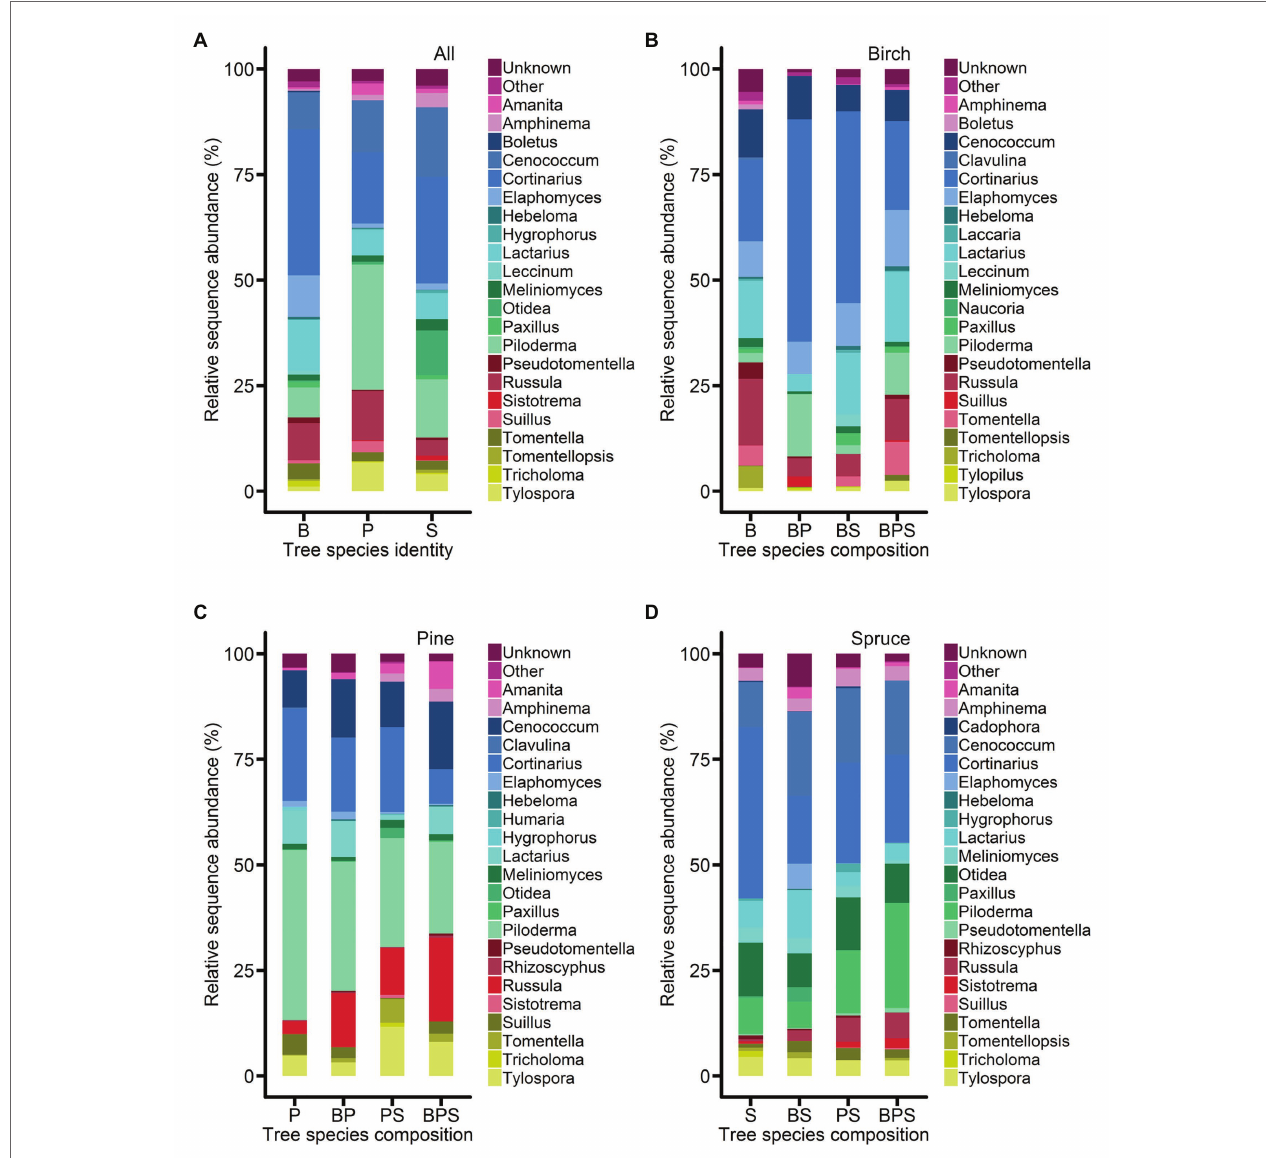
FIGURE 1 | Abundances of major ectomycorrhizal (EcM) fungal genera (A) on the roots of Betula pendula , Pinus sylvestris , and Picea abies . Abundances of major EcM fungal genera on the roots of (B) Betula pendula , (C) Pinus sylvestris , and (D) Picea abies in different forest stands (monoculture and mixed stands). The data represent the mean values of the relative abundances of ITS2 amplicons expressed as percentages. B, birch; P, pine; S, spruce; BP, birch-pine; BS, birch-spruce; PS, pine-spruce; and BPS,